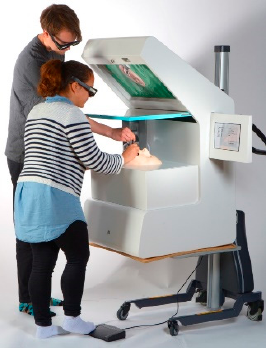
Figure 1. The structure of the Kobra simulator during virtual surgery.